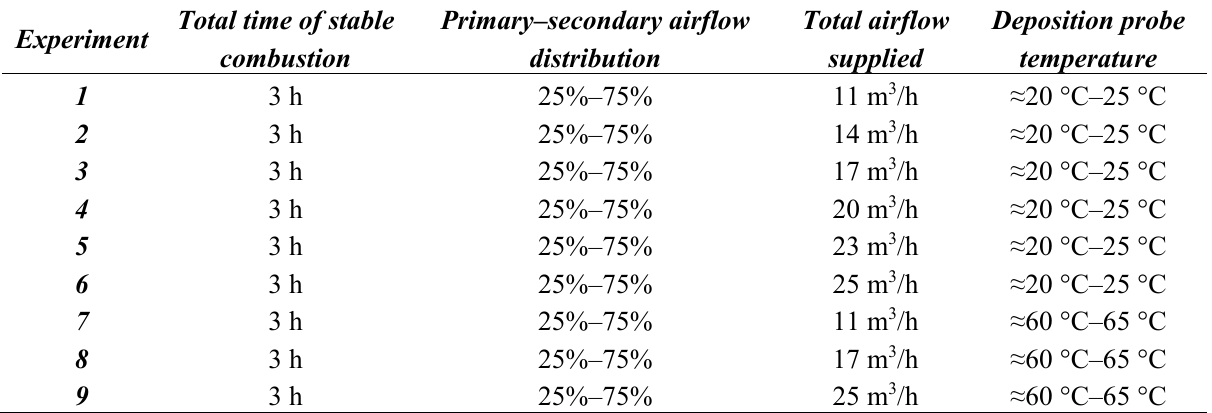
Table 2. Description of the combustions